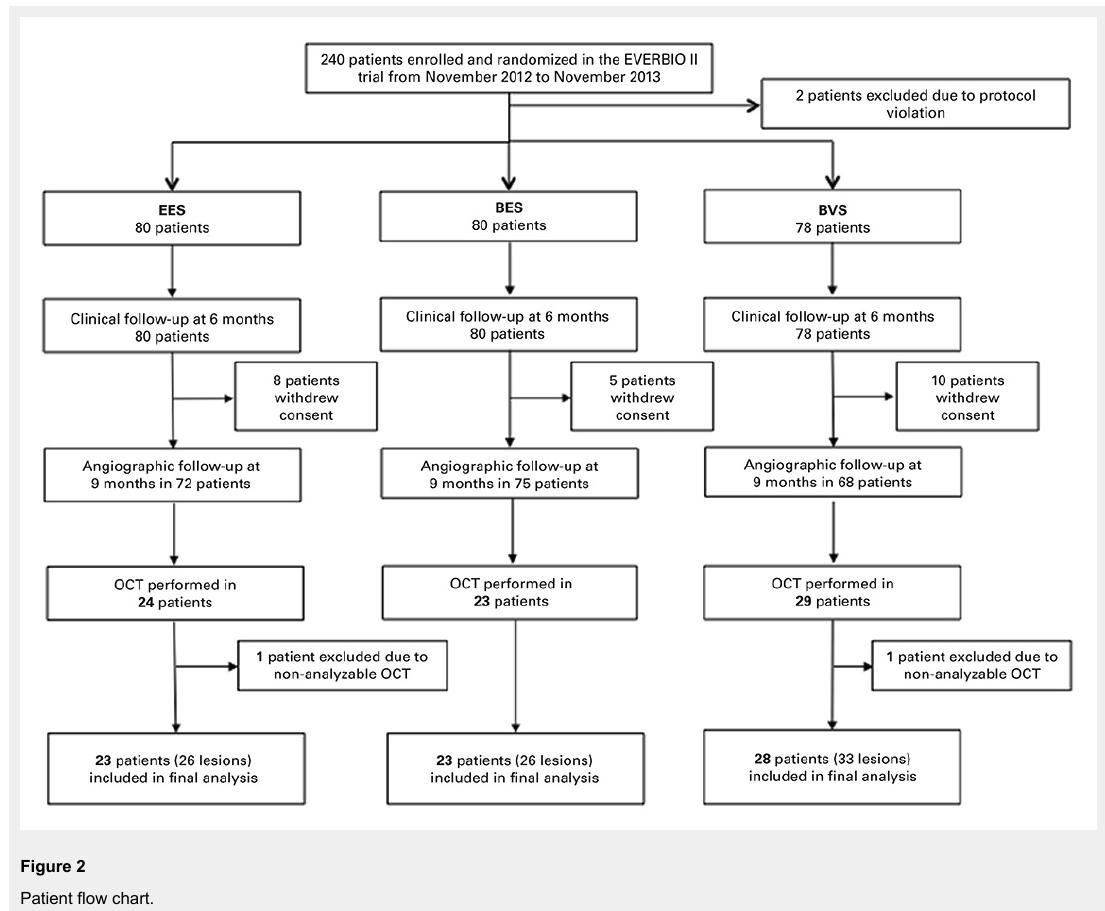
Figure 2 Patient flow chart. BES = biolimus-eluting stent; BVS = bioresorbable vascular scaffold; EES = everolimus-eluting stent; OCT = optical coherence tomography